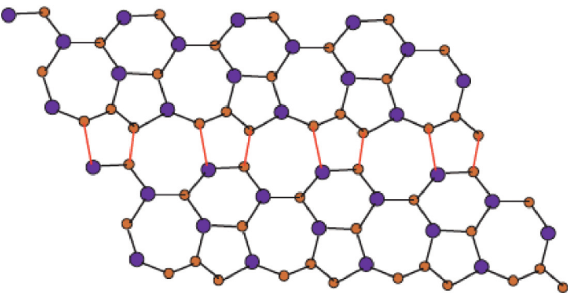
Figure 4: Sheet of Si